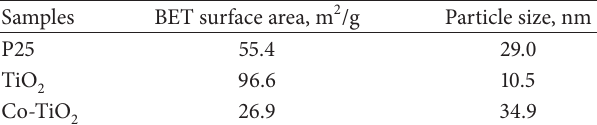
Table 1: BET surface area of photocatalysts. Samples